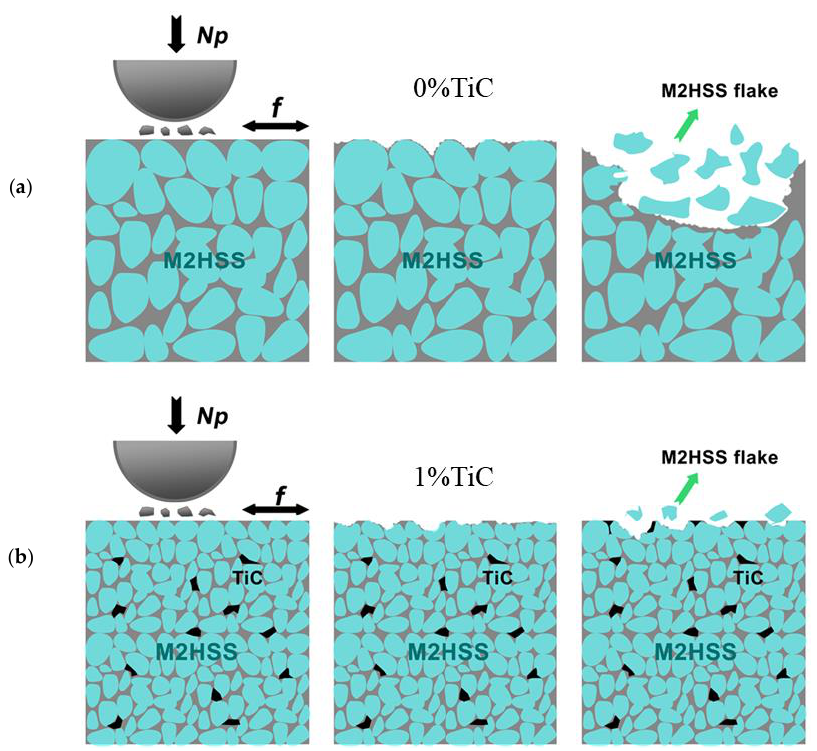
Figure 12. Schematic of the friction and wear mechanisms of the different alloys: ( a ) M2 HSS, ( b ) 1%TiC/M2HSS.